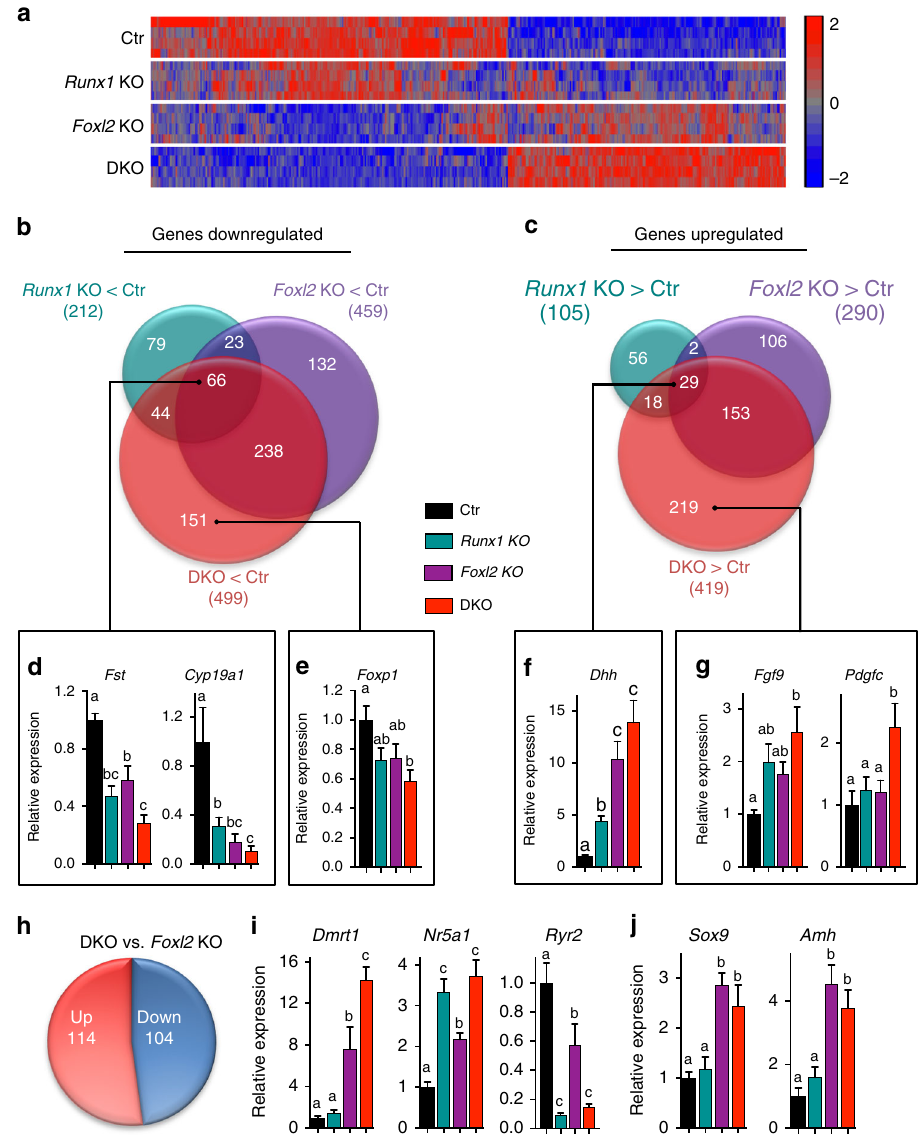
Fig. 7 Transcriptomic analysis of XX Runx1 / Foxl2 single and double KO ovaries. a Heat map for the 918 genes differentially expressed in XX Runx1/Foxl2 double knockout (DKO) vs. XX control (Ctr) gonads at birth. The heat map shows the expression of these 918 genes in XX control, Runx1 KO, Foxl2 KO, and Runx1/Foxl2 DKO gonads (microarray; n = 4/genotype; one-way ANOVA; fold change > 1.5, p < 0.05). Controls correspond to XX wild-type littermates. b , c Venn diagram comparing the genes downregulated ( b ) or upregulated ( c ) in XX Runx1 KO (green circle), XX Foxl2 KO (purple circle), and XX Runx1/ Foxl2 DKO (red circle) gonads at birth. d – g Validation by quantitative PCR of genes identi fi ed in the Venn diagrams as signi fi cantly downregulated in all three KO ( d ), or only in Runx1/Foxl2 DKO ( e ), or signi fi cantly upregulated in all in all three KO ( f ) or only in Runx1/Foxl2 DKO ( g ). h , i Identi fi cation of the genes differentially expressed in XX Runx1/Foxl2 DKO vs. XX Foxl2 KO gonads and validation of candidate genes by quantitative PCR. j Expression of Sox9 and Amh is not changed in XX Runx1/Foxl2 DKO compared with XX Foxl2 KO gonads. For all the qPCR data, values are presented as mean ± SEM ( n = 5/genotype). One-way ANOVA, p < 0.05. Bars with different letters ( a , b , c ) are signi fi cantly different. Source data are provided as a Source Data fi